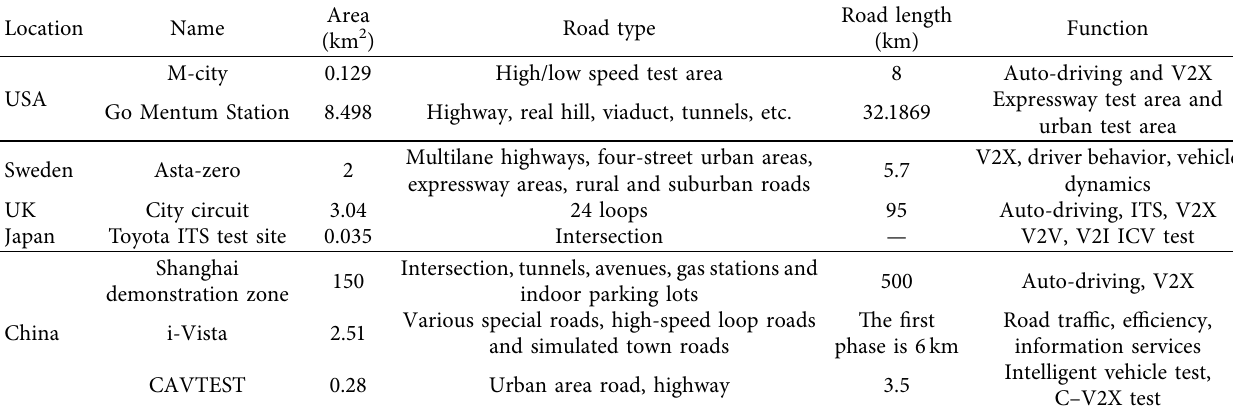
Table 5: Partly test sites for vehicles in the